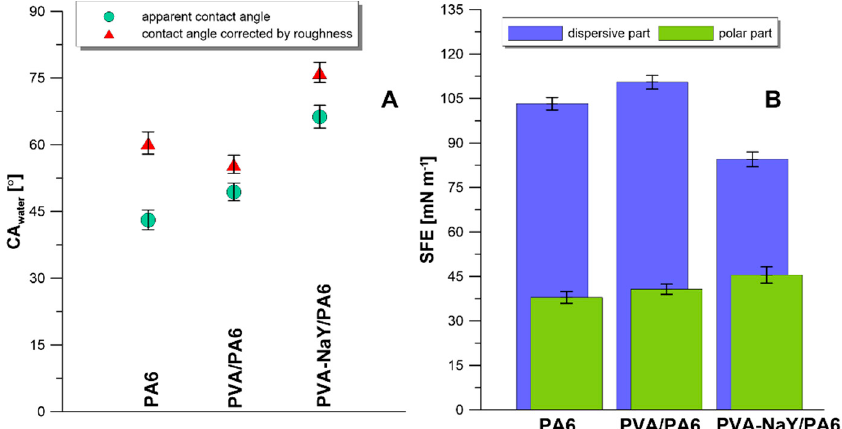
Figure 10. Apparent and corrected contact angle (CA) of water ( A ) and surface free energy ( B ) for porous support, PVA/PA6, and PVA/NaY/PVA composite membranes.